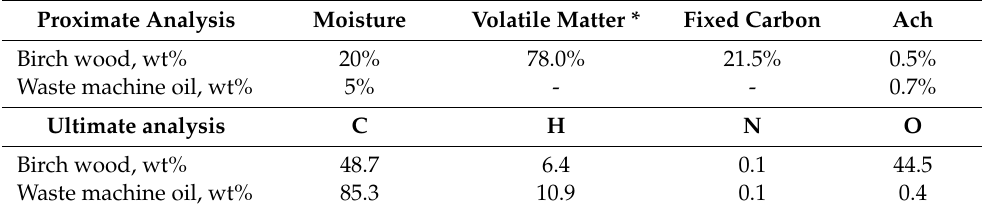
Table 2. Proximate and ultimate analyses of birch wood and waste machine